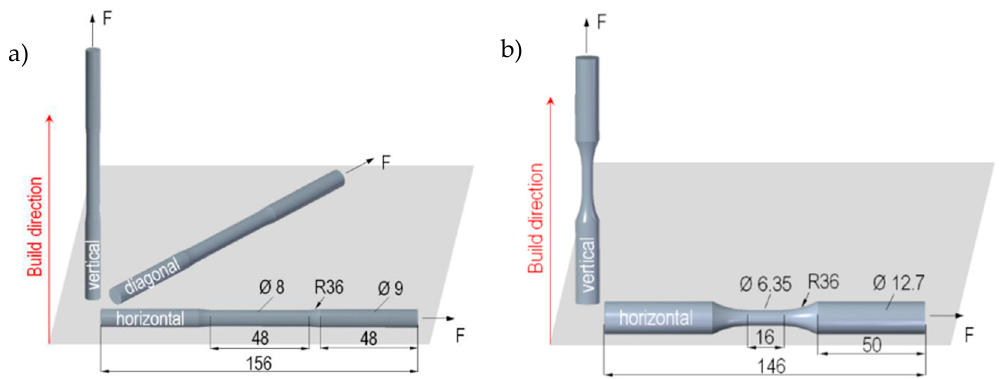
Figure 1. Specimen design in mm and build directions for ( a ) monotonic tensile tests and ( b ) fatigue tests. Table 1. Chemical compositions of Ti-6Al-4V ELI powders (wt%) [33].